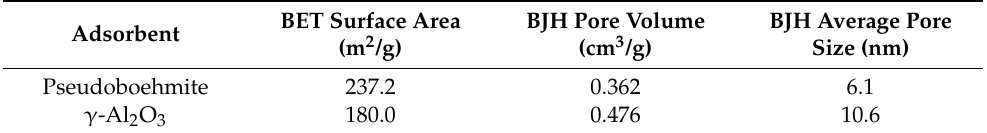
Table 2. Textural properties of pseudoboehmite and γ -Al 2 O 3